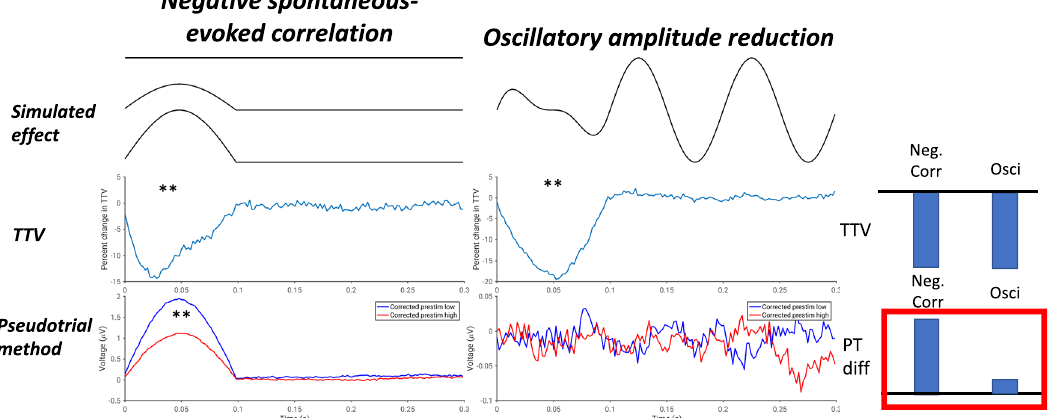
Fig. 4 Results of simulation to disentangle methodological inconsistencies of Fig. 3. In each column, a schematic of the simulated effect is plotted ( “ simulated effect ” ), along with the normalized trial-to-trial SD ( “ TTV ” ), and the results following application of the method of pseudotrials ( “ pseudotrial method ” ). * p < 0.05, ** p < 0.01. Bars at the right show a schematic of the results: both simulations show a decrease in TTV, but only the simulation with a genuine correlation between spontaneous and evoked activity shows a difference with the method of pseudotrials. N = 48 simulated participants.